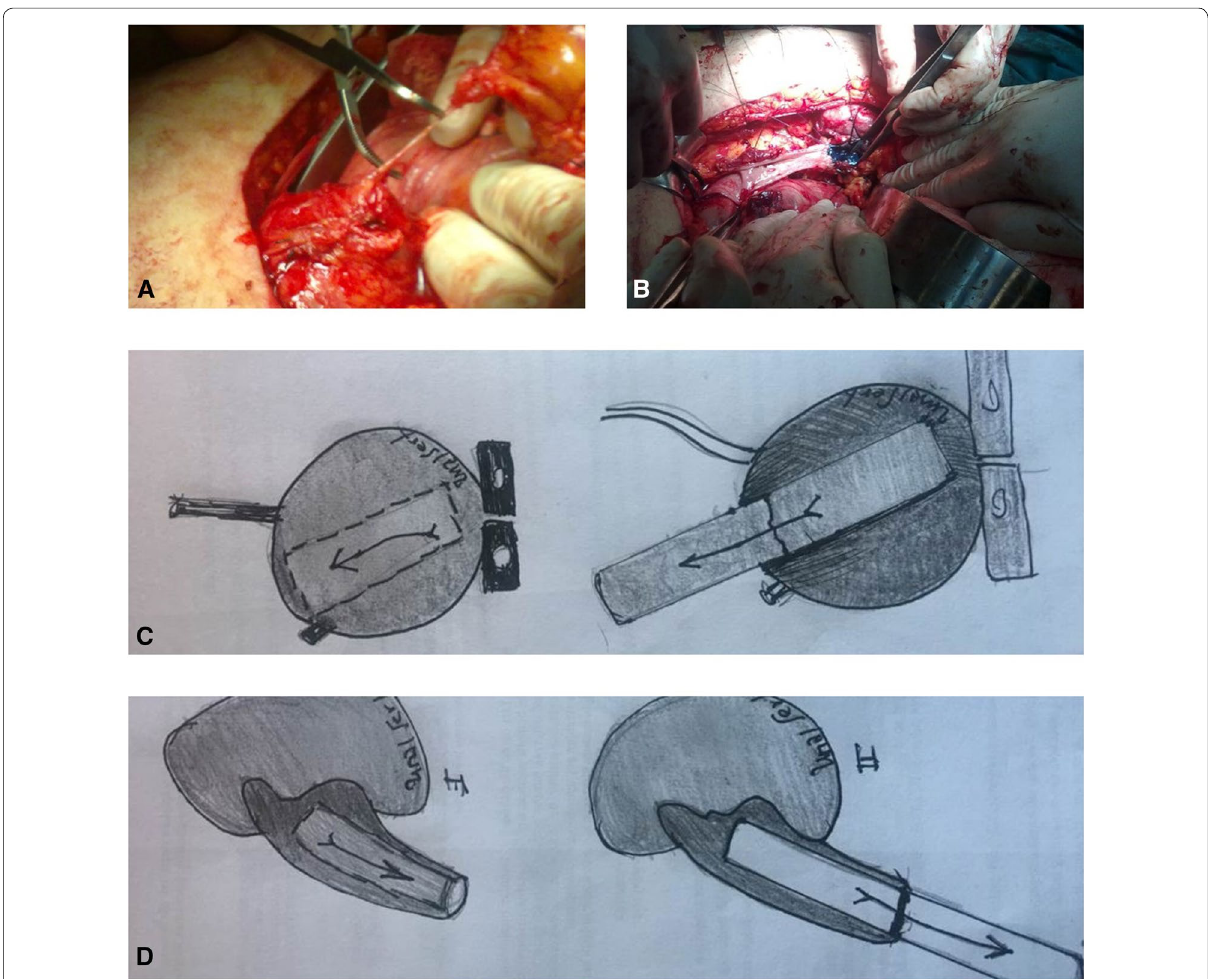
Fig. 3 Boari flap technique. a Avulsiye ureter, b boari flap & renal pelvis flap anastomosis, c boari flap drawing, d renal pelvis flap